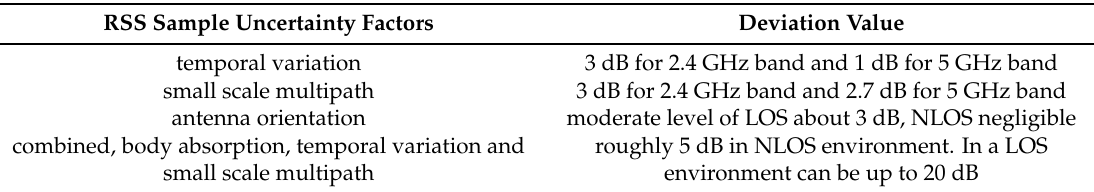
Table 1. Summary of measured deviations of uncertainties related to the RSS